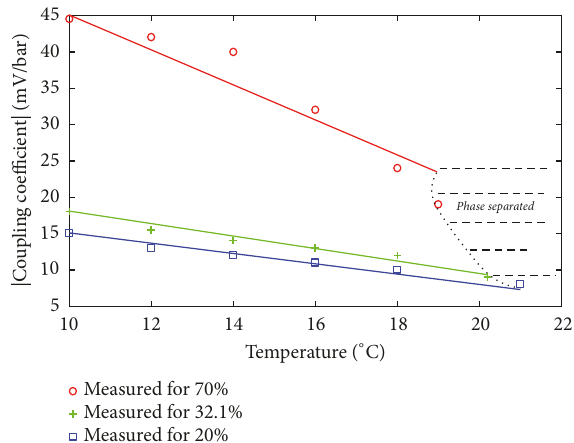
Figure 8: Streaming potential coefficient as a function of tempera- tureat3differentmassfractionsofTEA(20%,32.1%,and70%mass). The symbols are the measured data. The solid lines are the fitting ones.